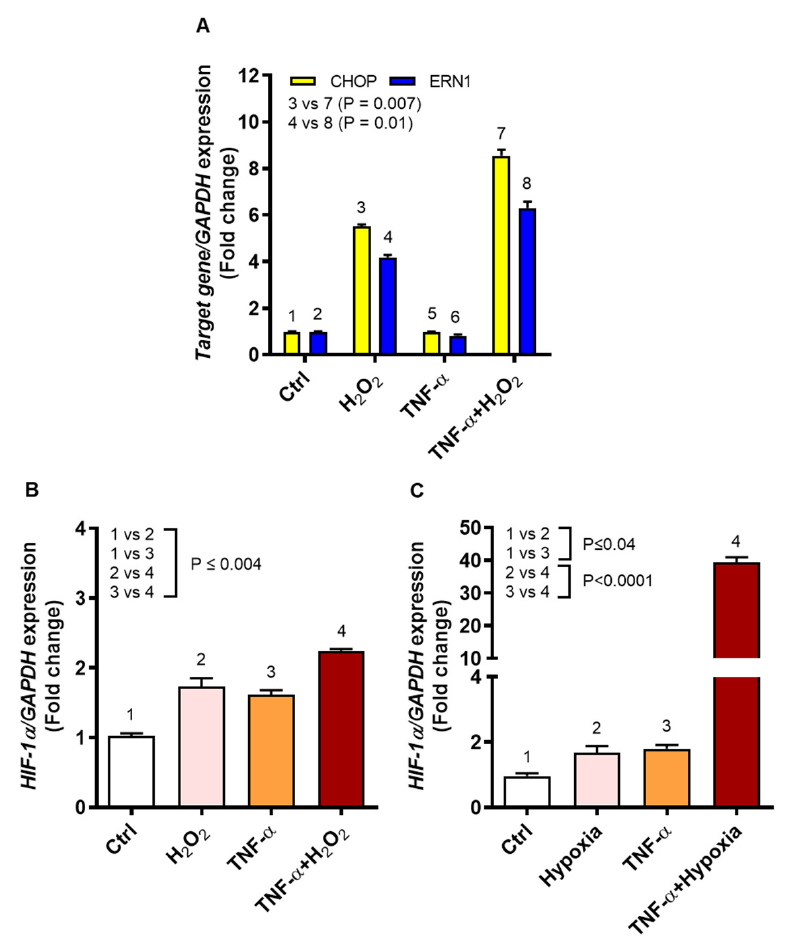
Figure 7. TNF- α /ROS cooperativity induces the ER stress and HIF1A stabilization. THP-1 cells were stimulated, in triplicate, with TNF- α (10 ng/mL), H 2 O 2 (10 mM), and/or 1% hypoxia, while control cells were treated with vehicle only. Total RNA was purified for assessing gene expression of ER stress markers (CHOP and ERN1) and oxygen sensor (HIF1A) using qRT-PCR as detailed in methodology. As appropriate, one-way ANOVA (Tukey’s multiple comparisons test) or two-way ANOVA was used to calculate group differences and p -values less than 0.05 were considered as significant. The representative data (mean ± SEM) from two independent experiments with similar results show increased expression of: ( A ) CHOP and ERN1 in cells co-stimulated with TNF- α and H 2 O 2 compared to cells treated with H 2 O 2 alone ( p ≤ 0.01); ( B ) HIF1A in cells co-stimulated with TNF- α and H 2 O 2 compared to treatments with TNF- α or H 2 O 2 alone ( p ≤ 0.004); and ( C ) HIF1A in cells stimulated with TNF- α under hypoxia as compared to TNF- α treatment under normoxia or induction by hypoxia alone ( p <